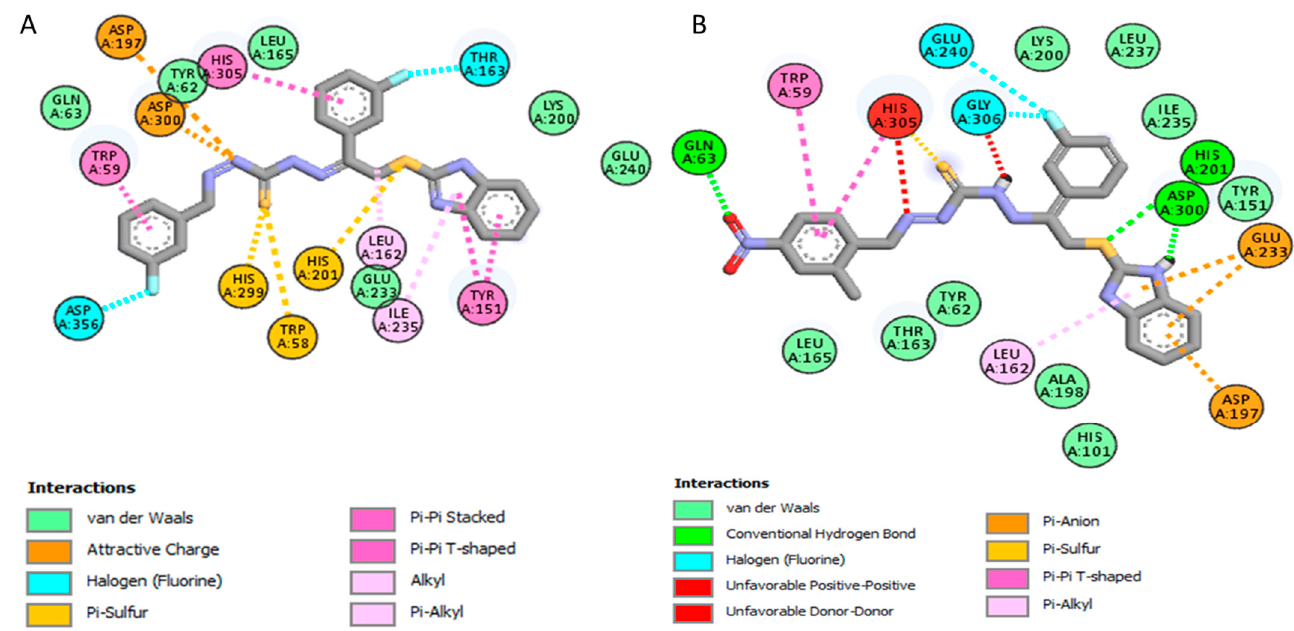
Figure 9. Profile for potent compounds against α -amylase indicates the surface of the corresponding enzyme represent the PLI profile for compound ( A ) 19 and ( B ) 20. Table 2. Showed nine different poses of analogue 13 with varied binding